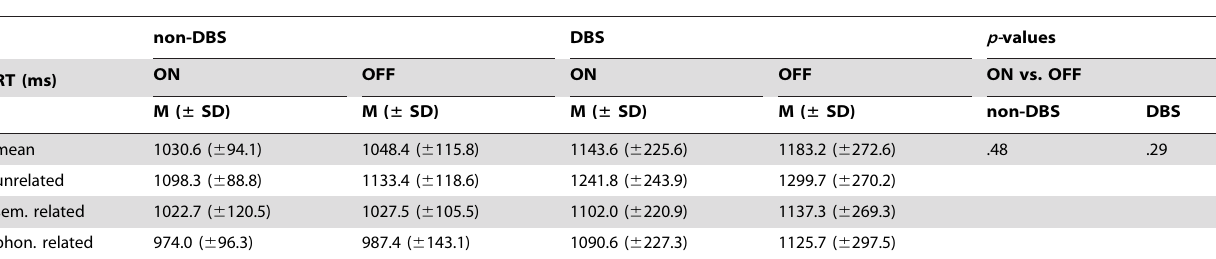
Table 4. Lexical Decision